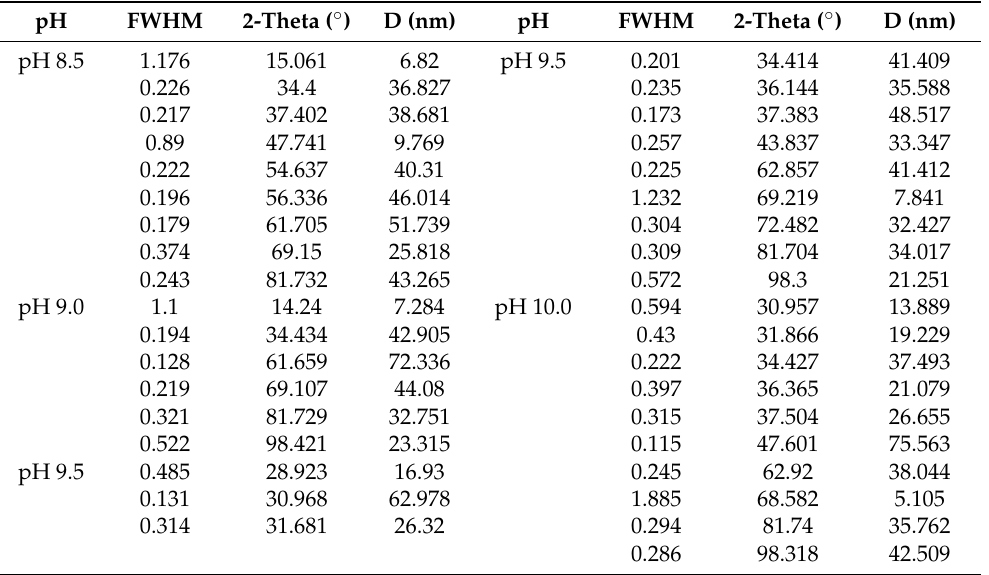
Table 2. List of pH, FWHM, 2theta, and D (according to the Scherrer equation: D (nano crystallite size) = K λ / β cos θ